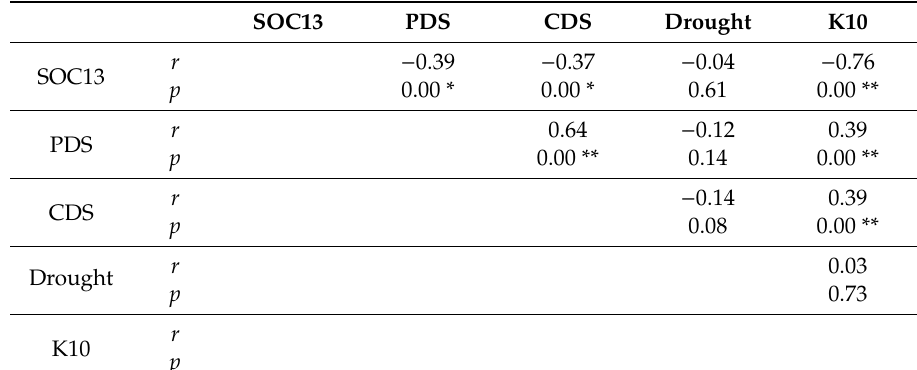
Table 5. Univariate analysis to test correlations between the 13-item version of the sense of coherence (SOC) scale (SOC13), K10, PDS, CDS and drought condition.